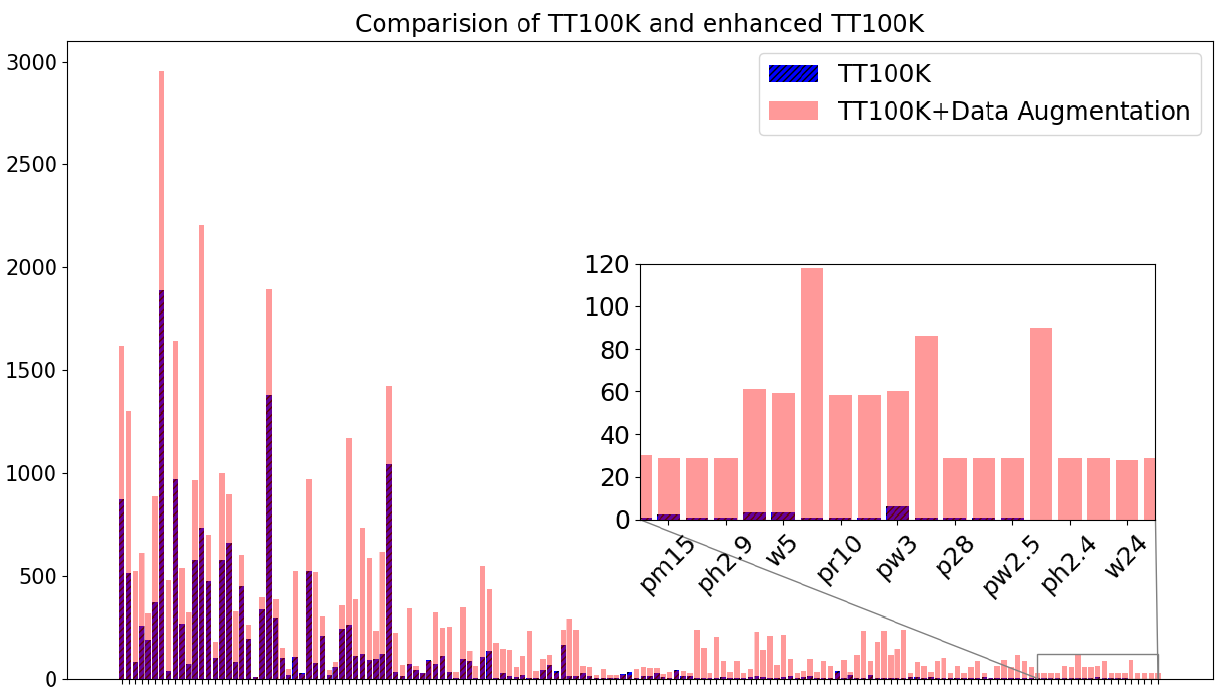
Figure 2. Comparison diagram of TT100K and enhanced TT100K traffic sign category distribution.